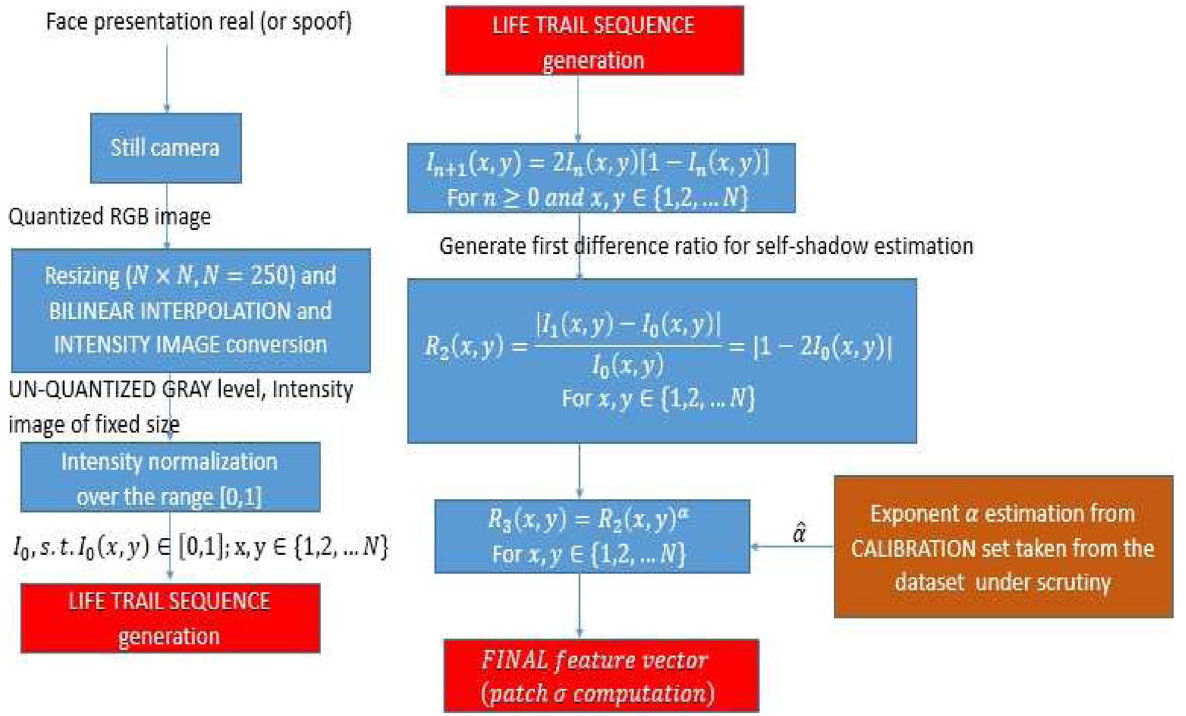
Fig. 1 Block-diagram of feature extraction